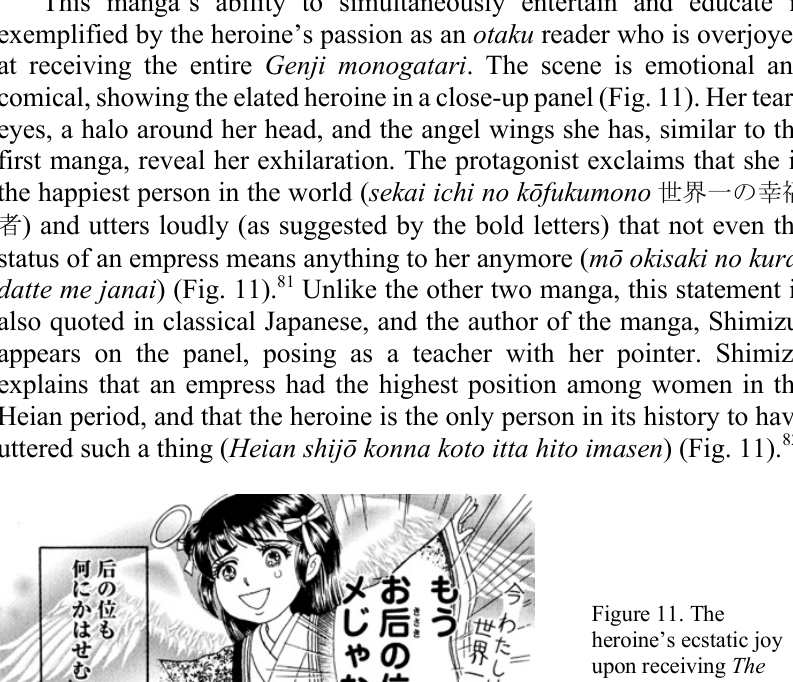
Figure 11. The heroine’s ecstatic joy upon receiving The Tale of Genji makes her feel like “the happiest person in the world” (Shimizu 2014, 41). Courtesy of